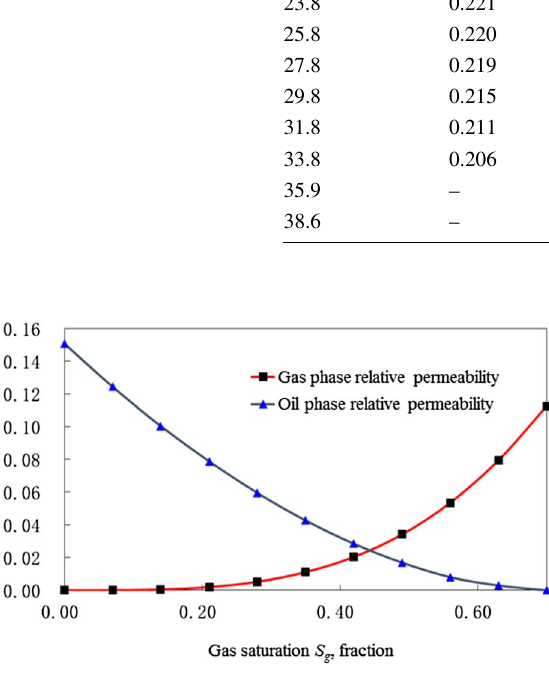
Fig. 1 Oil and gas relative permeability curve of a condensate gas reservoir